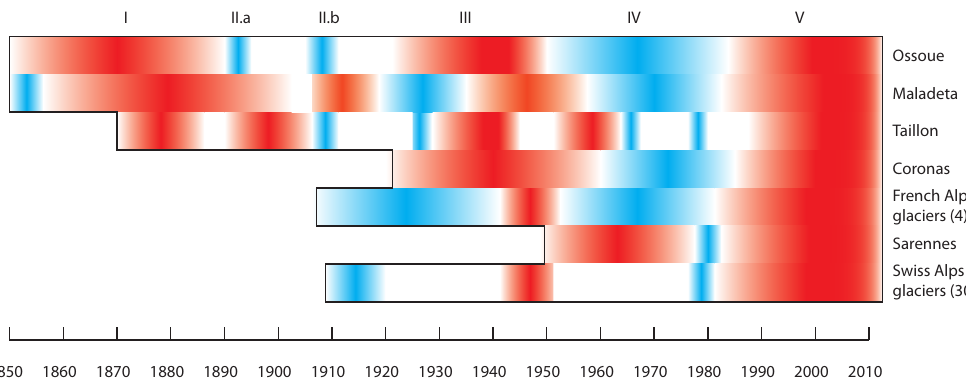
Figure 10. Comparison of Ossoue Glacier fluctuations with other Pyrenean and Alps glacier reconstructions. The ice depletion periods are shown in red. The accumulation or stable periods are shown in blue. Periods considered as “undetermined” are shown in white. The meta-data relative to the glaciers fluctuations are given in Table 4. For the localization of the glaciers, please refer to Fig. 5. Roman numerals above Ossoue Glacier fluctuations refer to the main periods of variation identified (Sect. 5.1). Table 6. Mean temperature (Pic du Midi, 2874m), mean precipitation (Tarbes, 374m), and correlations between mean temperature and precipitation time series and time (Spearman’s ρ ). Time ranges are based on the interpretation of the glacier metrics (Fig. 9). Significant correlations ( p values < 0.05) are marked with asterisks. For 1858–1890, the mean temperature is based on the CRU data set. Time range Period Mean Mean ρ s ρ s (glacier periods)(number of years) of the